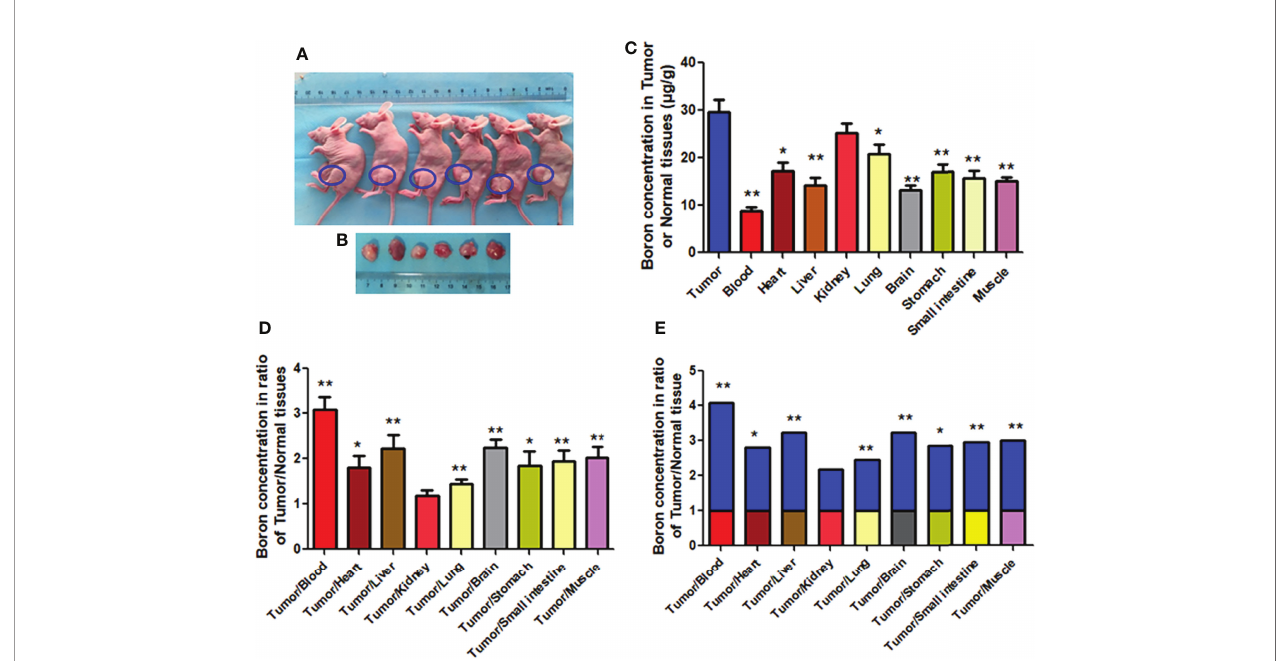
FIGURE 6 | Boron concentration in gastric tumor or tissues of CDX mice. (A , B) Mice bearing tumor. (C) The boron concentration in tumor, blood, and tissues of heart, liver, kidney, lung, brain, stomach, small intestine, and muscle. (D , E) Boron concentration ratios in tumor/blood or tumor/tissue. Data were expressed as the means ± SD. N = 6. The dose of BPA was 250 mg/kg body weight. The age of female mice was 8 weeks. Blood and tissues were collected at 1 h after BPA injection for boron measurement. * p < 0.05, ** p < 0.01 compared with tumor or tumor/tissue.